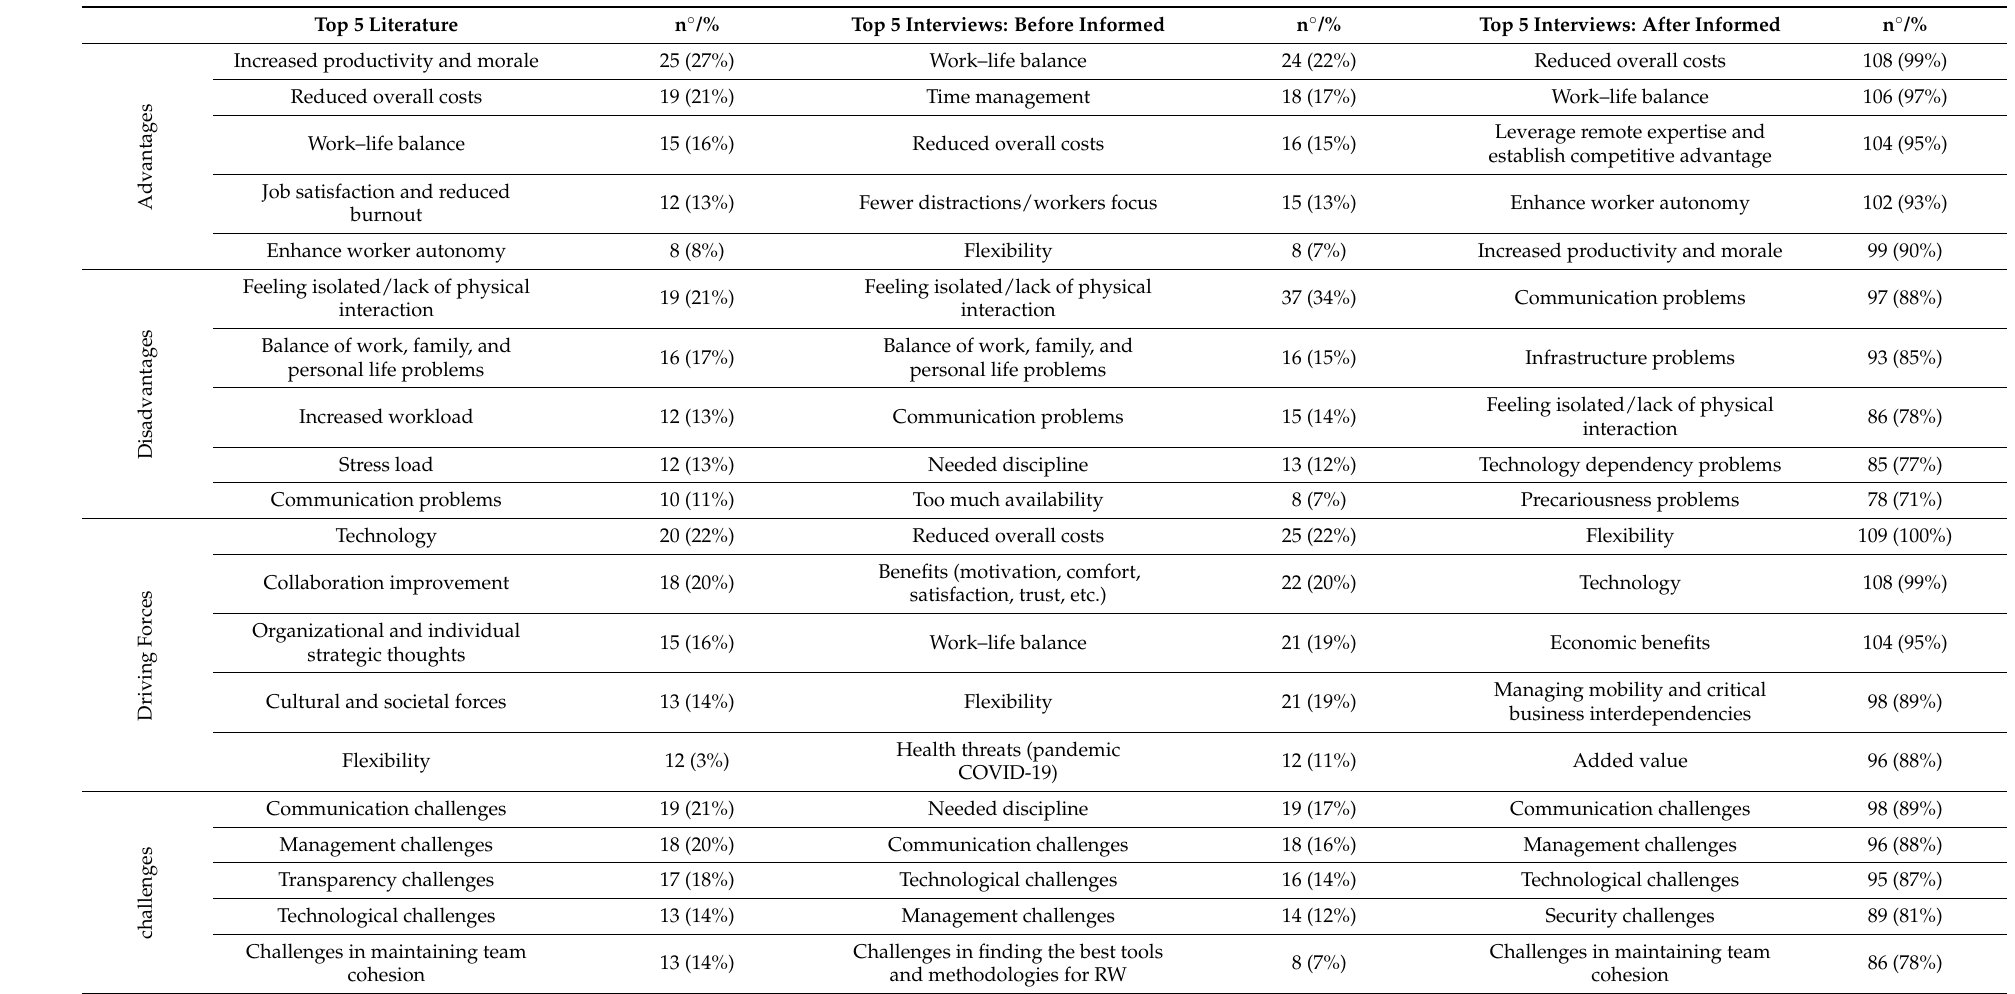
Table 8. Top 5 RW decision factors from both literature and